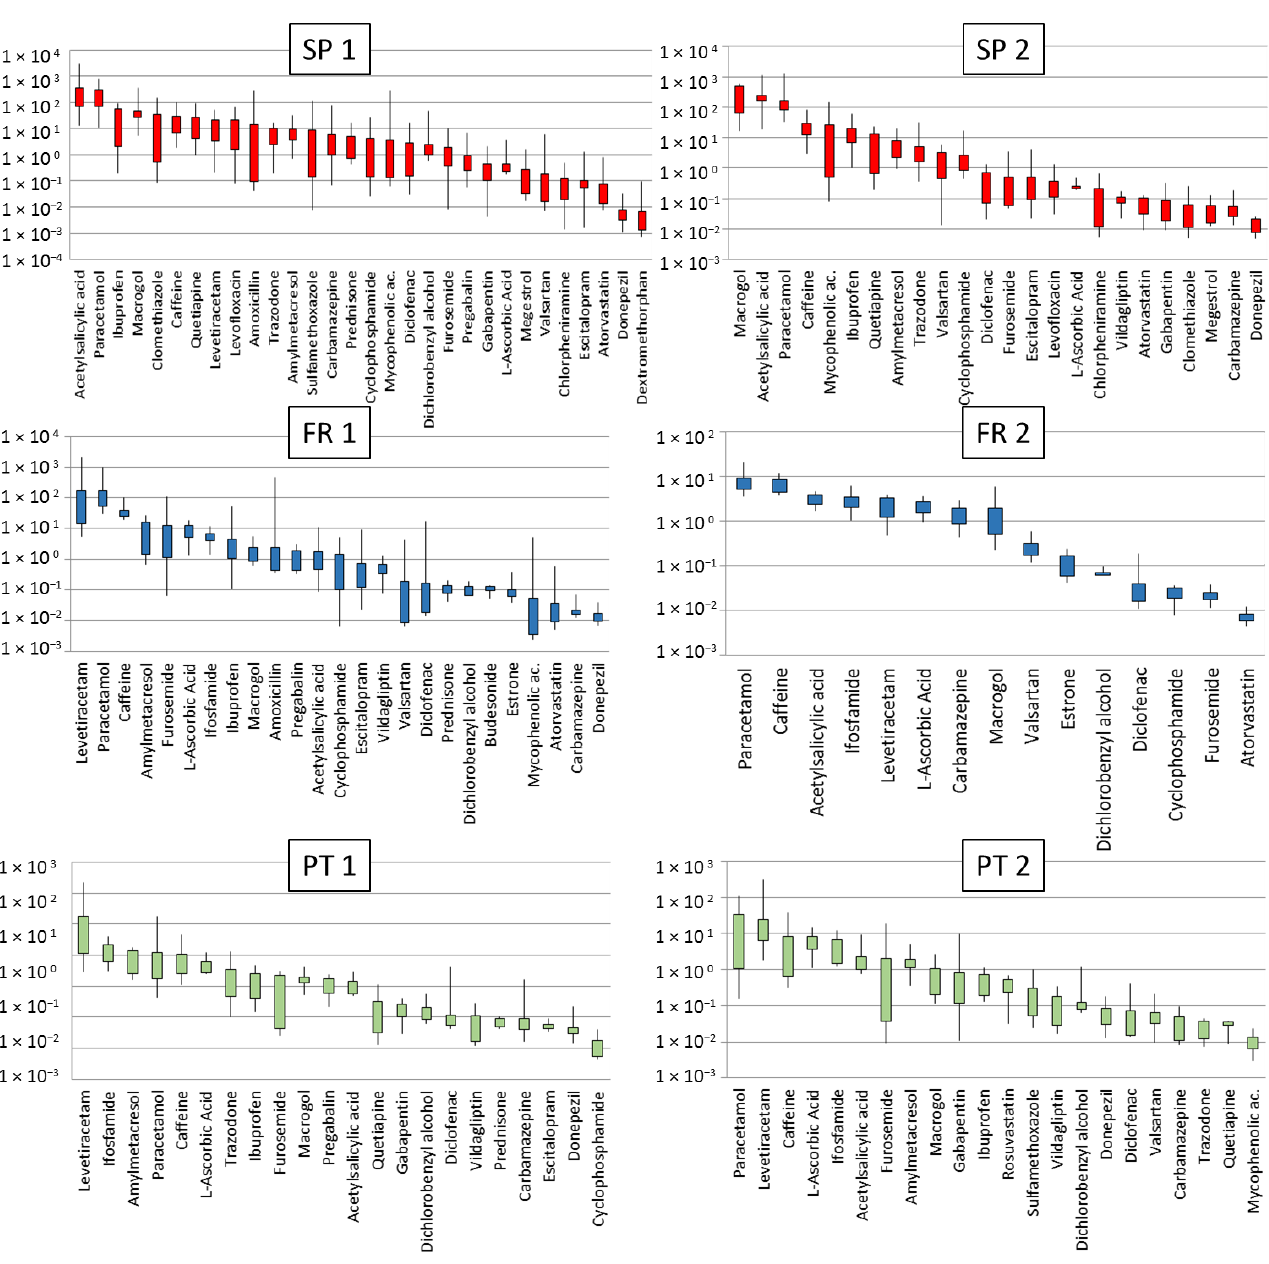
Figure 2. Boxplots indicating the minimum, maximum, 25th and 75th percentile concentrations of the different drugs detected ( µ g L − 1 ) in more than 50% of the samples in each senior residence, ordered from the highest to lowest concentrations (red SP, blue FR and green PT). The Y axis is in logarithmic scale to allow better comparison.